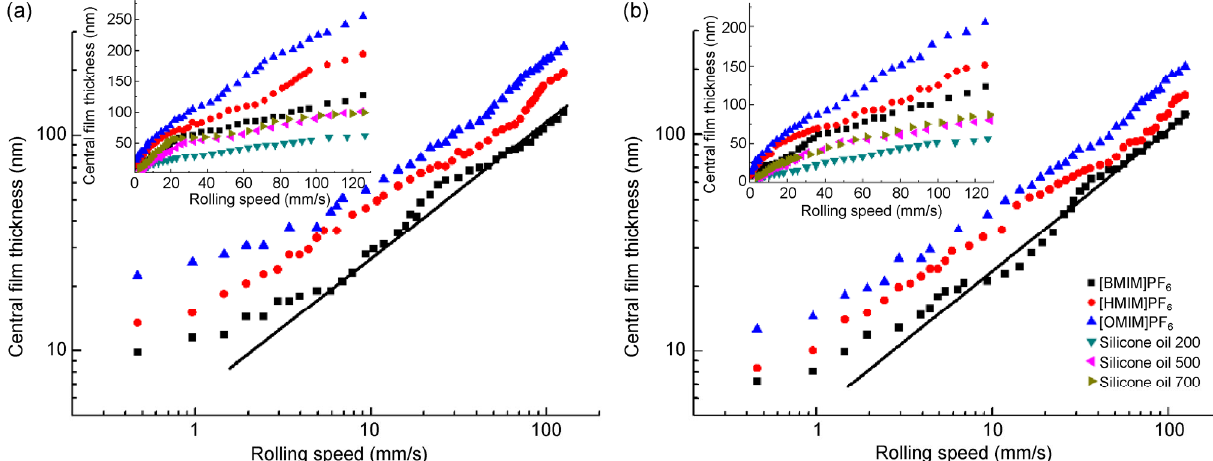
Fig. 13 Film formations of ionic liquids and silicone oils at (a) pressure of 1 GPa, (b) 3 GPa measured by Xiao et al. [89]. Copyright 2010, Springer Science+Business Media,